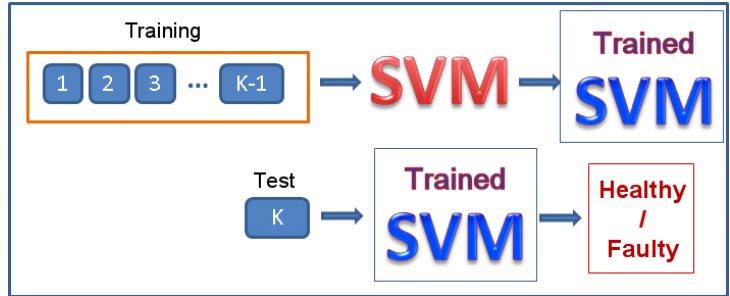
Figure 9. Scheme about training and classification for the iteration of k feature in the ’leave one out cross validation’ training algorithm.